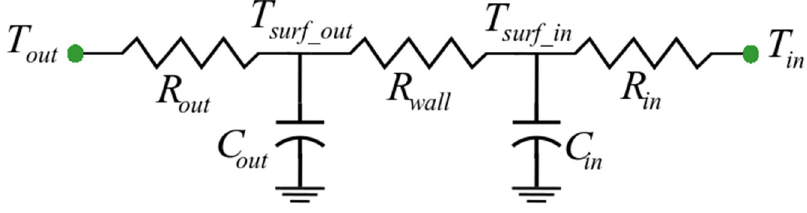
Figure 4. Wall heat-transfer model.